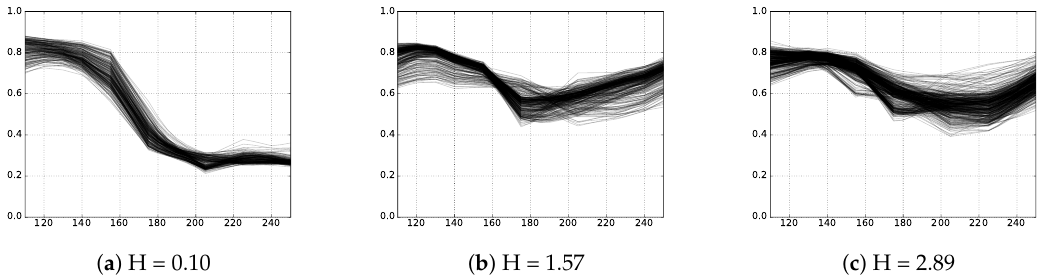
Figure 3. SPOT5 NDVI temporal profiles of all the pixels belonging to three grasslands along the H gradient: ( a ) grassland with a low level of biodiversity, ( b ) grassland with a medium level of biodiversity and ( c ) grassland with a high level of biodiversity. The floristic record of these three grasslands can be found in Appendix A, Table A1. The x-axis corresponds to the day of the year of 2015, and the y-axis corresponds to the NDVI. Grasslands have been voluntarily chosen by their high number of pixels for better